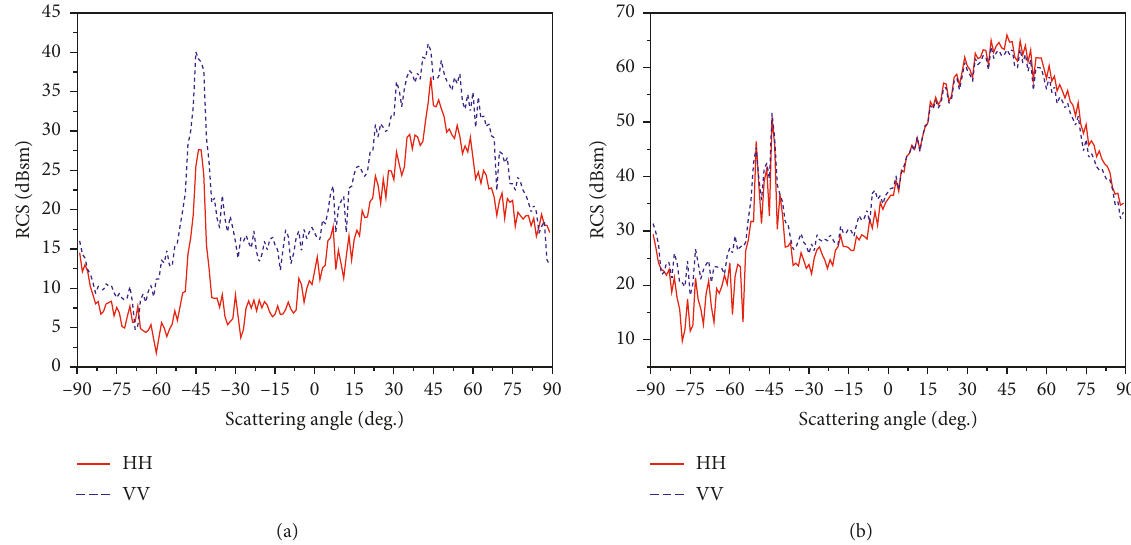
Figure 16: The change of RCS of coupling field and total field from the ship and sea surface with different polarization. (a) Coupling field. (b) Total